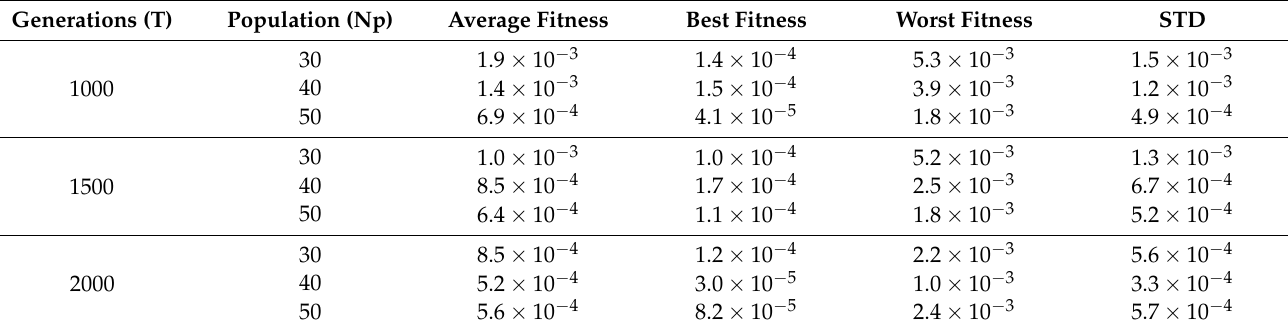
Table 4. AO parameter analysis for case 3.